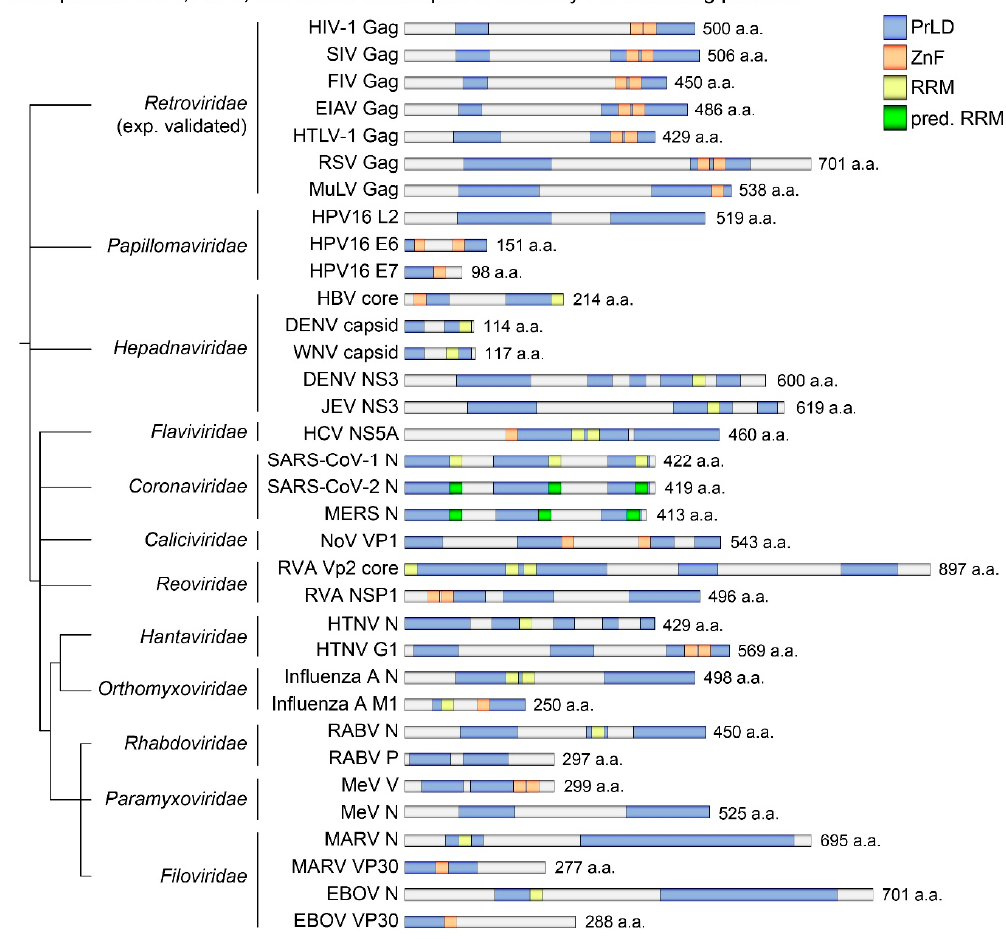
Figure 1. Phylograms of pan-virus proteins containing juxtaposed PrLDs, ZnFs, and RRMs. Members of distantly linked virus families were imported into phyloT (http://phylot.biobyte.de) [30] and ITOL (Interactive Tree of life; http://itol.embl.de) [76] to render phylogeny trees. Predictor of Natural Disordered Regions algorithm software (PONDR; http://www.pondr.com/) [73] with VLXT and VSL2 and default settings was used to map locations of PrLDs on viral proteins, analyzed using FASTA sequences, which were obtained from the NCBI protein sequence database. Predicted PrLDs (blue) having a >0.8 score were scaled for presentation using Adobe Illustrator. ZnF (orange) and RRM (yellow) placements were determined from the NCBI protein sequence database and the literature, and in other cases, were identified using MOTIF Search (https://www.genome.jp/tools/motif/) and Prosite (https://prosite.expasy.org/) [74] , which were validated by examining sequences of known RNA-binding lysine, arginine, glycine, and histidine residues [75] . Experimentally validated (i.e., exp. validated) Retroviridae proteins included are those that undergo NC-, ZnF-, and Zn 2+ -mediated liquid-liquid phase separation (LLPS) [54]. PrLDs, prion-like domains; ZnFs, zinc fingers; RRMs, RNA-recognition motifs; pred. RRMs, predicted RNA-recognition motifs; a.a., amino acid; HIV-1, human immunodeficiency virus-type 1; SIV, simian immunodeficiency virus; FIV, feline immunodeficiency virus; EIAV, equine infectious anemia virus; HTLV-1, human T-cell leukemia virus 1; RSV, Rous sarcoma virus; MuLV, murine leukemia virus; HPV16, human papillomavirus 16; HBV, hepatitis B virus; DENV, dengue virus; WNV, West Nile virus; JEV, Japanese encephalitis virus; HCV, hepatitus C virus; SARS-CoV-1, severe acute respiratory syndrome coronavirus 1; SARS-CoV-2, severe acute respiratory syndrome coronavirus 2; MERS-CoV, Middle East respiratory syndrome-related coronavirus; NoV, norovirus; RVA, rotavirus A; HTNV, Hantaan orthohantavirus; influenza A, influenza virus; RABV, rabies lyssavirus; MeV, measles virus; MARV, Marburg virus; EBOV, Ebola